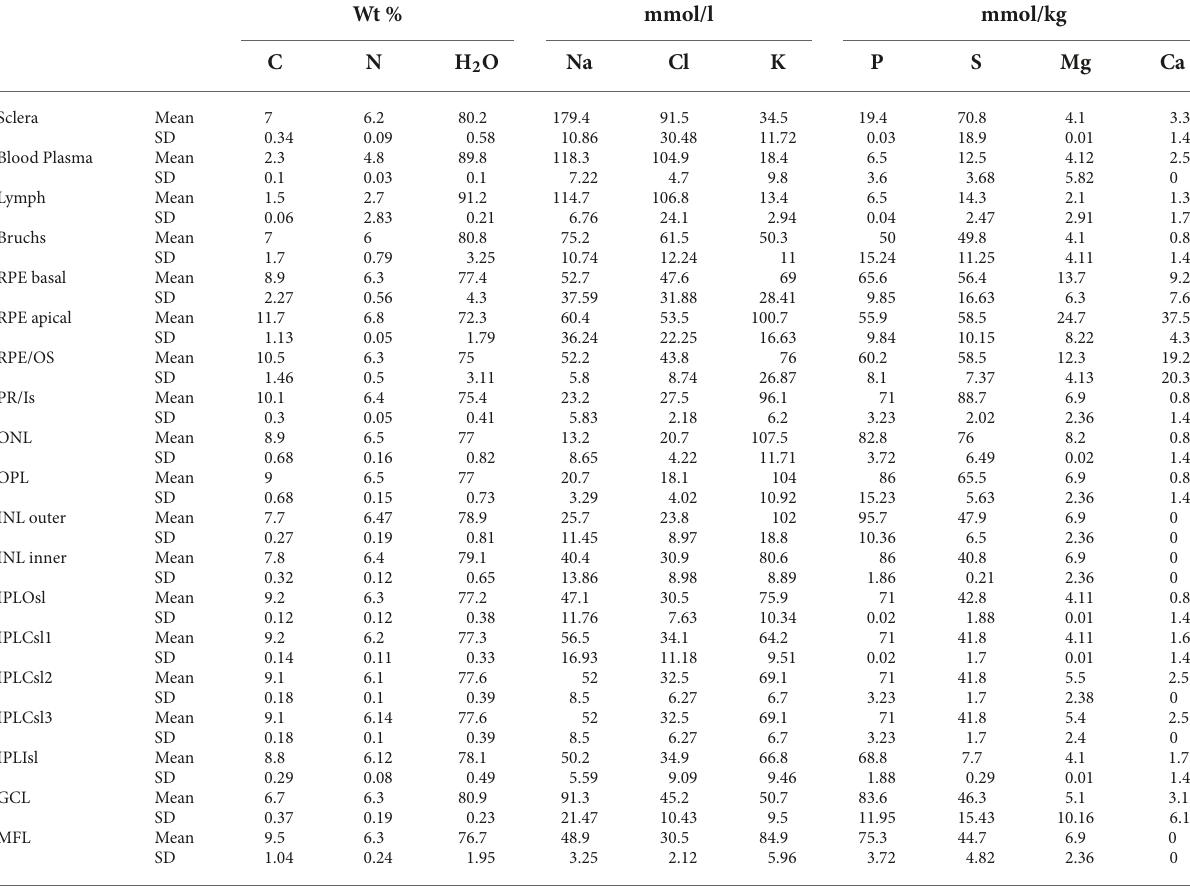
TABLE 1 Element concentration across the retinal complex with O concentrations converted to H 2 O